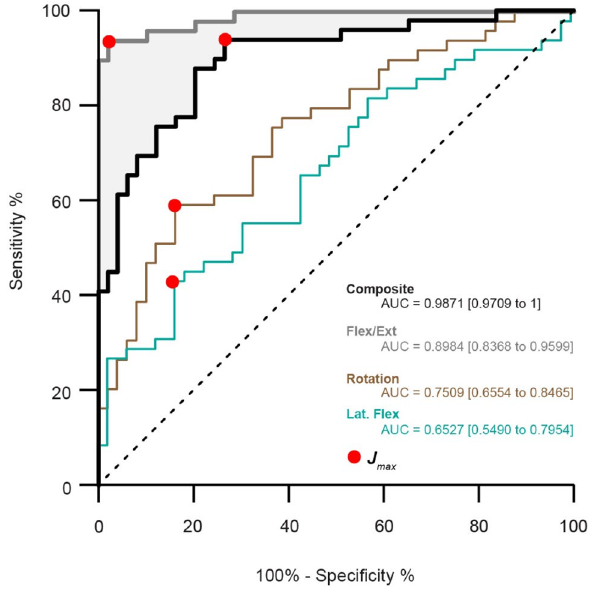
Figure 3. Receiver Operator Characteristic (ROC) curves for Trunk Compliance Index. Summary curves were produced for a Composite Trunk Compliance Index score (averaged across all perturbation directions, black), and individually for perturbations across each plane of motion (Flexion/Extension-grey; lateral flexion-blue; Rotation-brown). Area under the curve (AUC), and Youden’s index (J max ) indicating optimal cut-points are shown for measures with good to excellent discriminatory